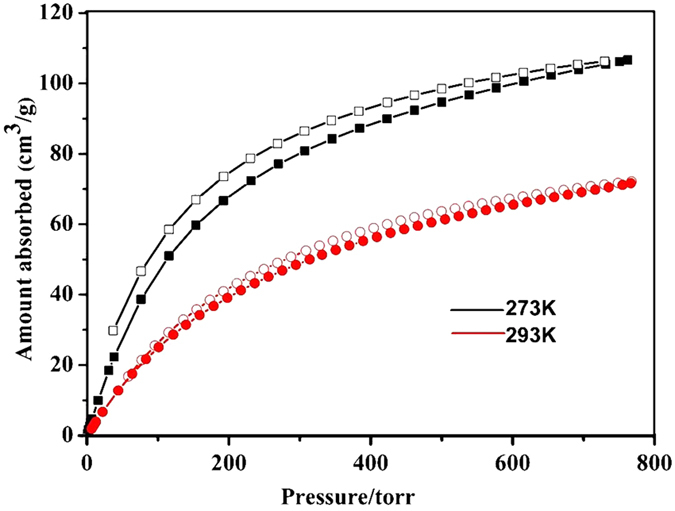
CO2 adsorption isotherms in Y-DDQ at 273 and 298 K.